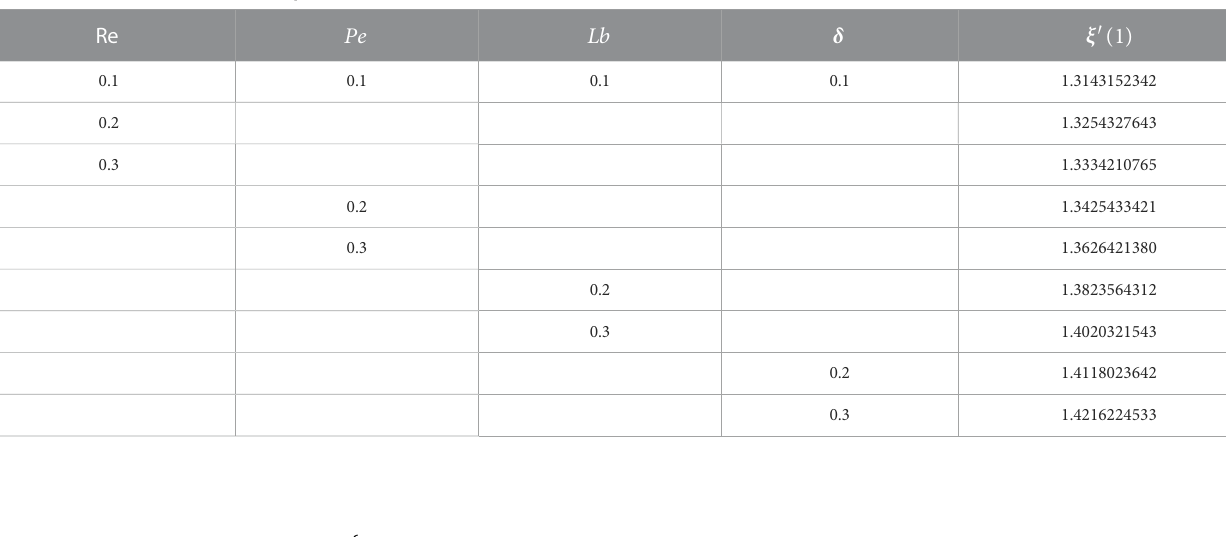
TABLE 5 Motile rate vs. the embedded parameters for the Maxwell nano fl uid. Re Pe Lb δ ξ ′ ( 1 )